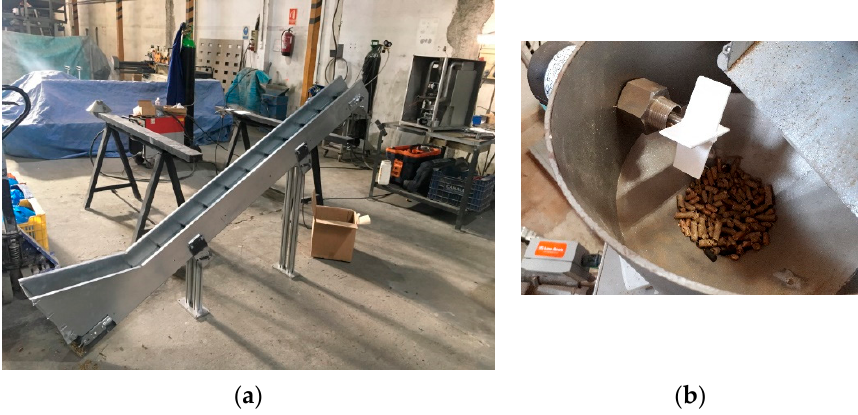
Figure 4. Conveyor belt: general view ( a ) and second storage unit ( b ).